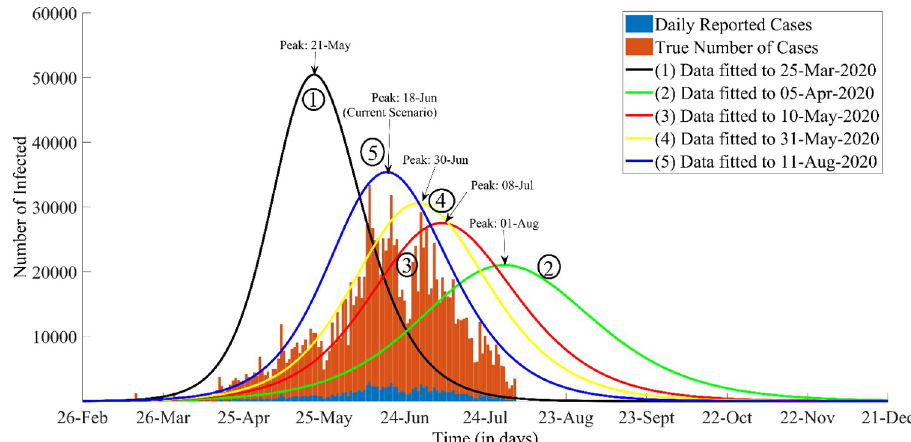
Fig 2. The Evolution of the COVID-19 modelling paradigm for different epidemic timelines in Sindh. The labelled graphs depict the number of infected individuals throughout the course of the epidemic. The curves correspond to the following important events: 1. The initial model outcome was based on the parameter values obtained from data for Wuhan, China and shows an unprecedented growth of the epidemic. 2. Initial Lockdown and community sensitization was more effective. The green plot depicts the most feasible outcome, had the preventive trend continued. 3. Testing Capacity increased from beginning of April onwards which is why more cases were being reported, shifting the data curves fitted till day 60 (red) further to the left of green curve. 4. A further surge in transmission was observed after 9th May was due to ease in lockdown, which pushed the peak of the yellow plot around 17% backwards. 5. It is evident from the blue plot (latest results) that due to the recent Eid celebrations and re-opening of non-essential businesses, the curve has moved further backward consequently hastening the peak of the epidemic Note: The blue stacked bars represent the daily reported cases and the brown stacked bars reflects the model assumption of having 10 times more (actual) cases than reported.